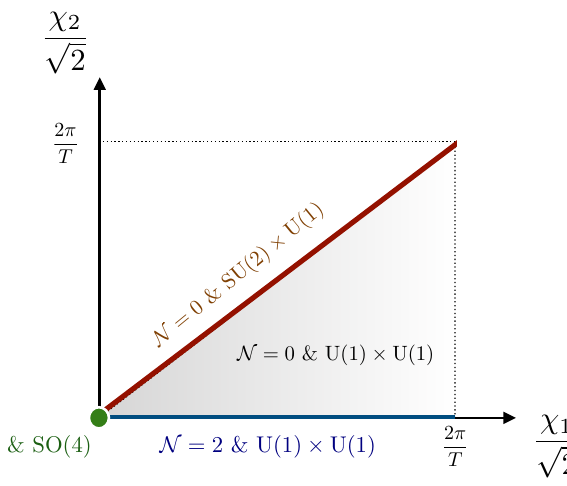
Figure 1 . Two-dimensional parameter space ( χ 1 , χ 2 ) of S-fold solutions induced by axion-like flat deformations of the N = 4 and SO (4) symmetric S-fold (green dot). The blue and red lines correspond to special choices of parameters χ 1 , 2 and produce supersymmetry (blue, χ 2 = 0 ) and residual symmetry (red, χ 1 = χ 2 ) enhancements. These two special lines define the boundary of the parameter